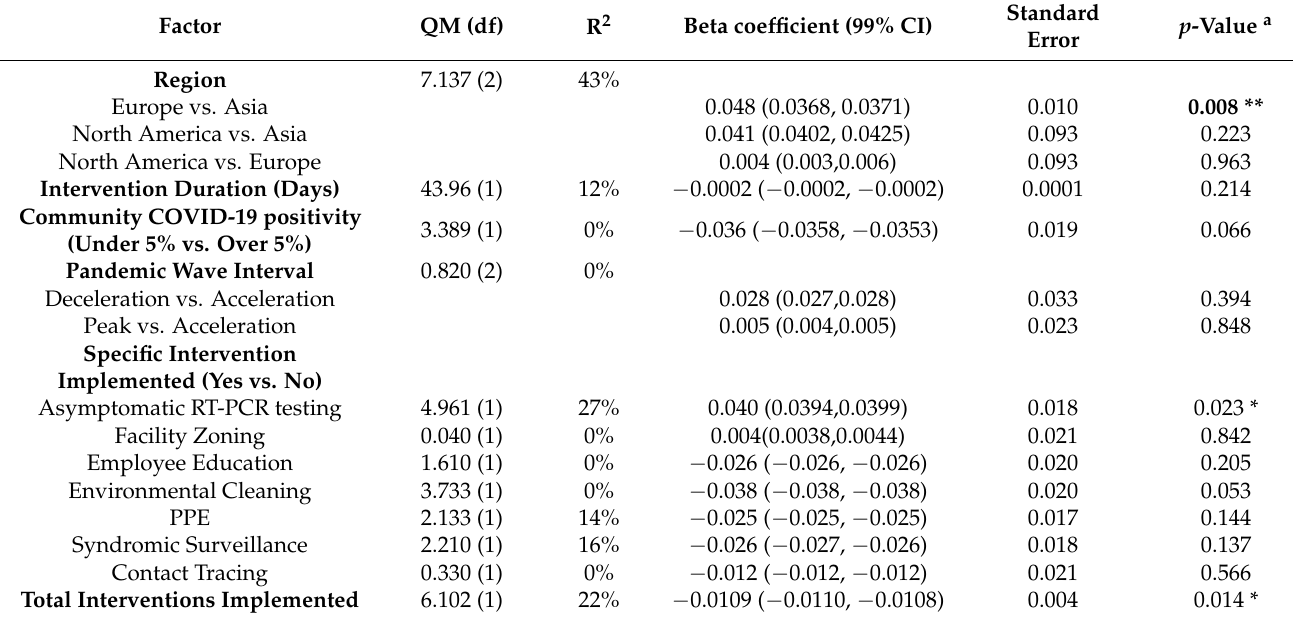
Table 8. Univariable meta-regression results for 15 studies that implemented combined IPC measures between January